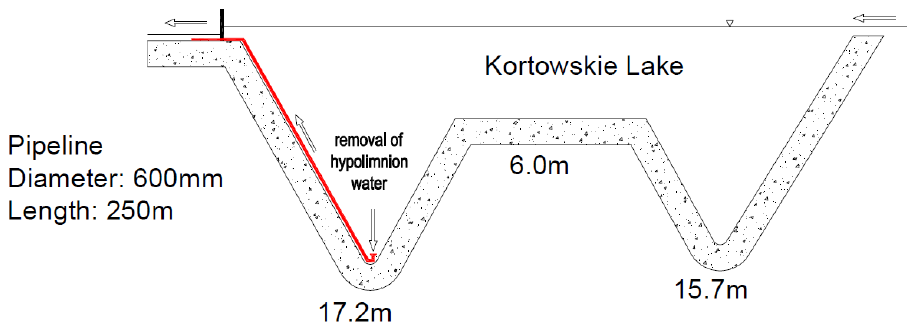
Figure 3. Scheme of Lake Kortowskie with hypolimnetic withdrawal installation.